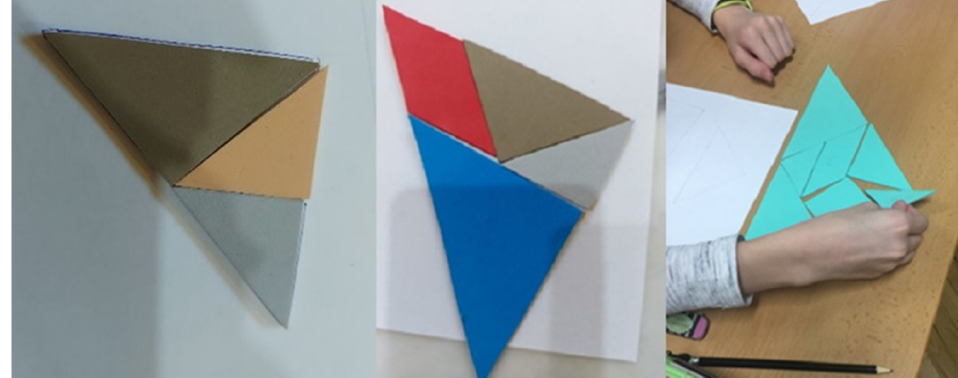
Figure 16. Creating triangles.